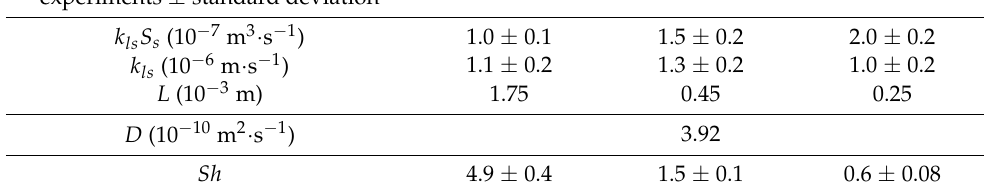
Hollow Beads Cylinders